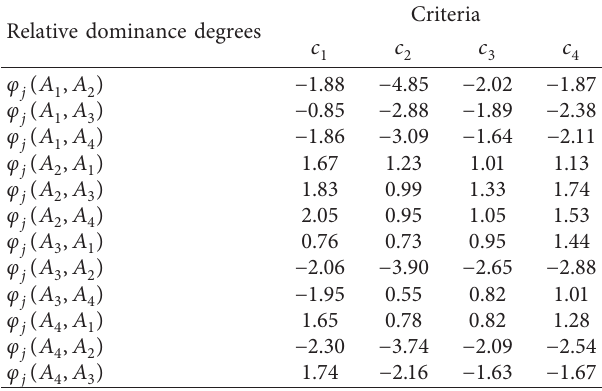
Table 8: Relative prospect dominance